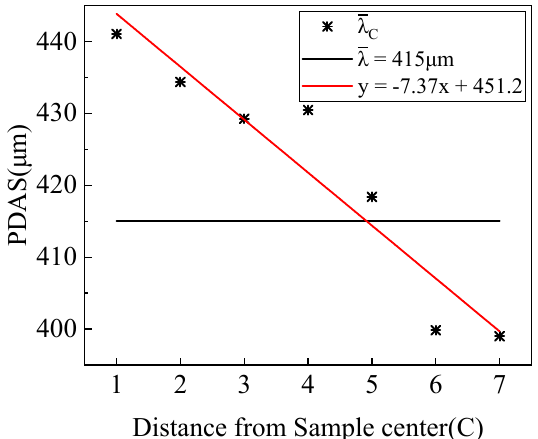
Figure 14. The relationship between the local PDAS and the distance from the center of the HT901 sample, Where the abscissas 1–7 represent the C1–C7 in Figure 13. λ C is the average local PDAS corresponding to C1–C7, and 𝜆 is the average local PDAS of HT901 which is defined in Figure 10a.